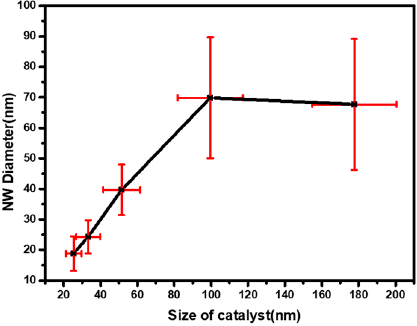
Figure 2. Relationship between the NW diameter grown at 750 °C and average size of the catalyst.